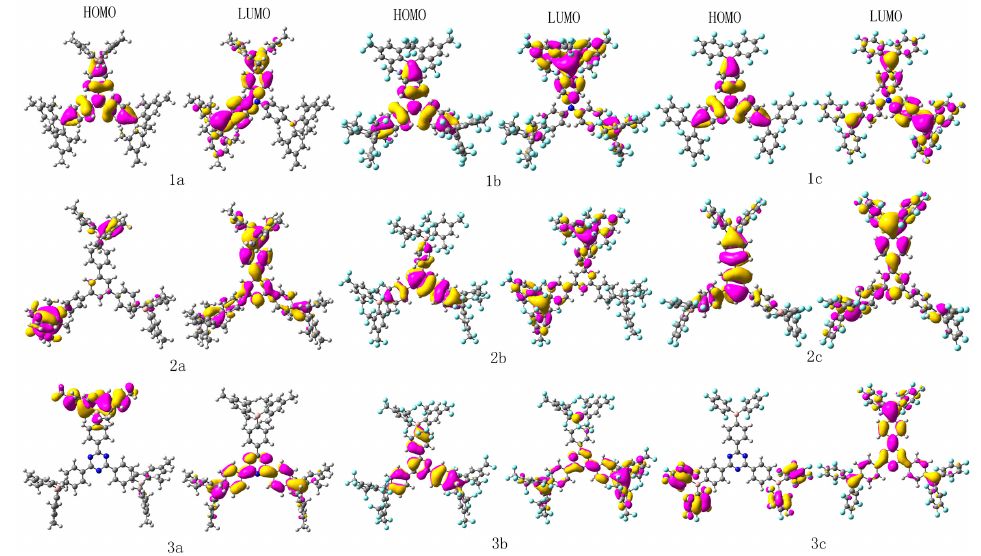
Figure 1. The electronic density contours of the frontier orbitals for the studied compounds at the PBE0/6-31G(d,p) level.